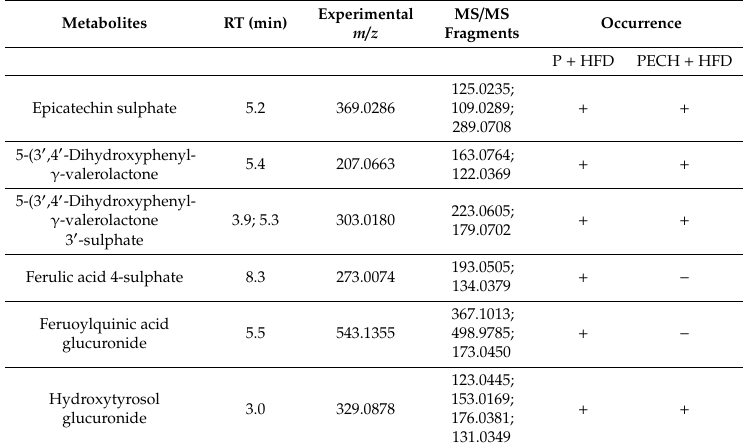
Table 2. Phenolic derived metabolites identified in